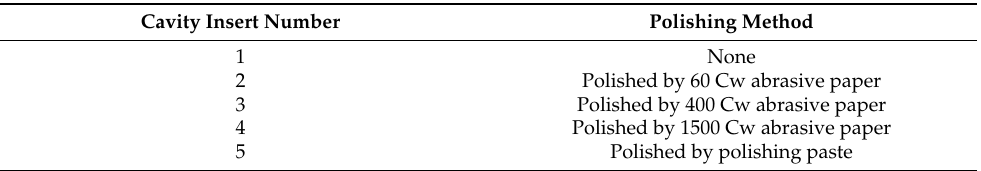
Table 1. The corresponding polishing method of each